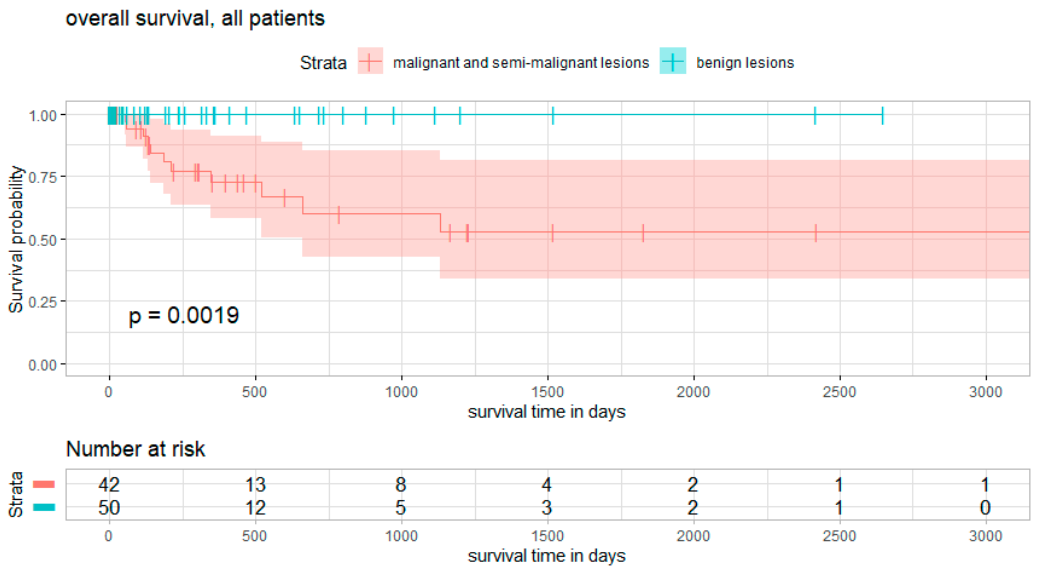
Figure 3. Overall survival. Survival curves for overall survival, subdivided into subgroups of benign lesions (blue) and malignant/semi-malignant lesions (red). Curve comparison shows significant differences between curves. Log rank test of benign vs. malignant/semi-malignant lesions: X 2 = 9.63, p = 0.00019.